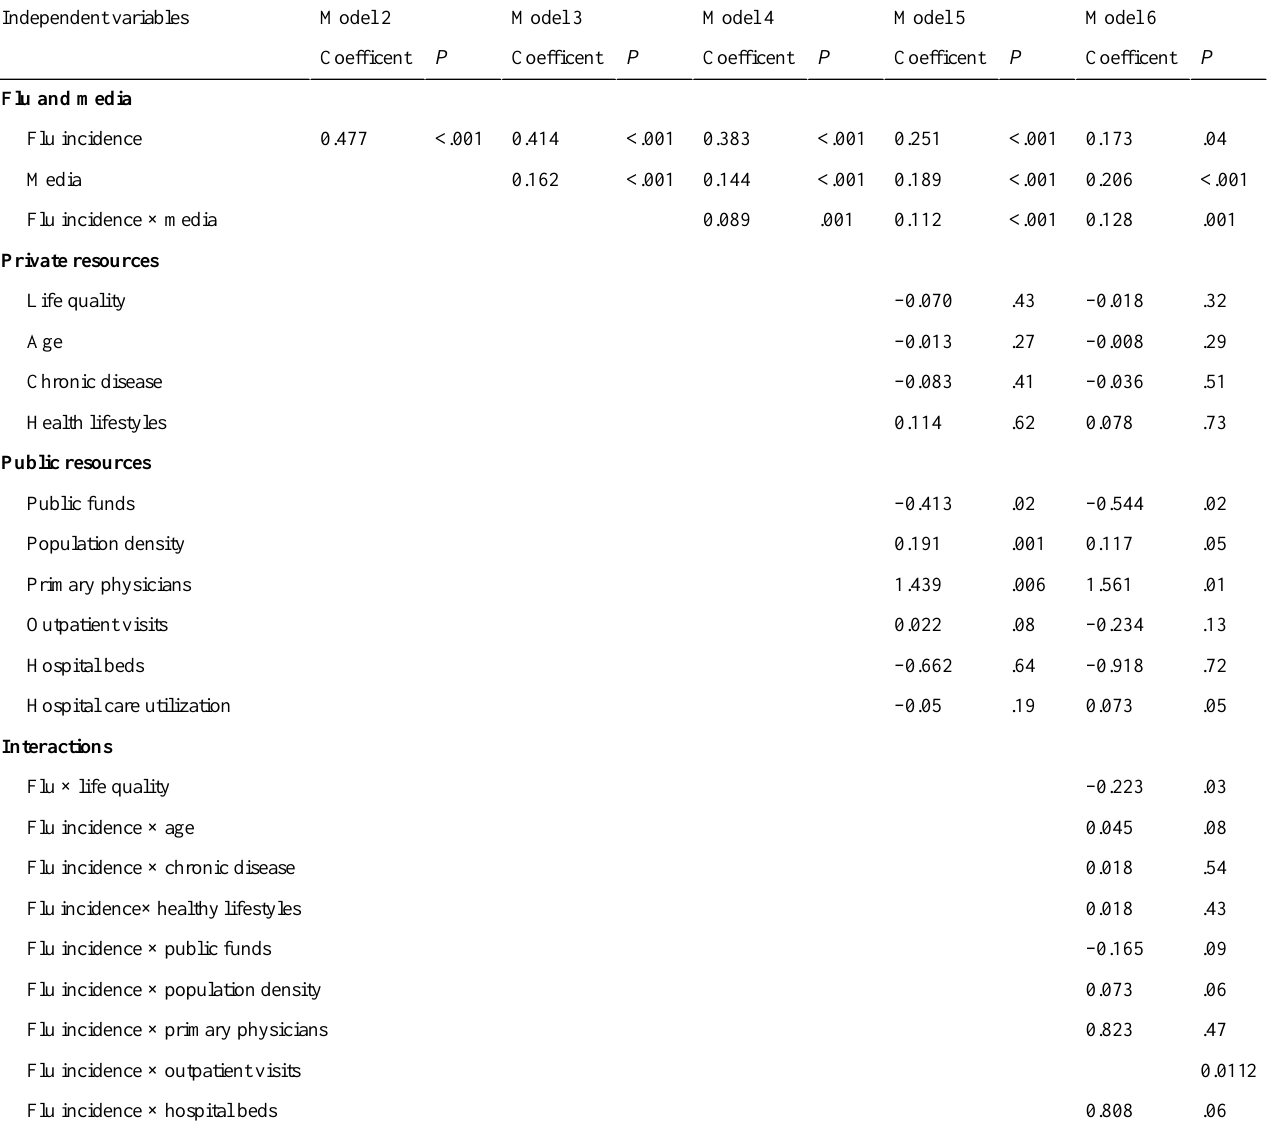
Table 10. Coefficient of determination ( R2 ) change and coefficient results for dependent variable flu